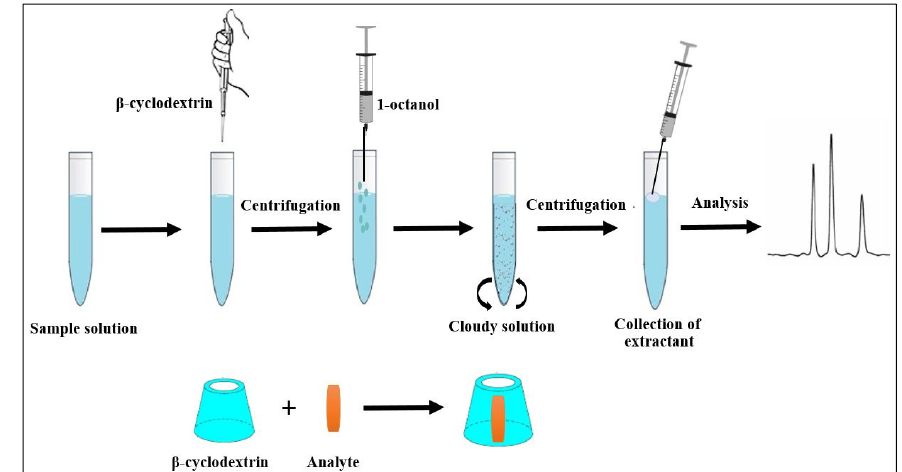
Figure 7. Schematic diagram of the proposed microextraction method .